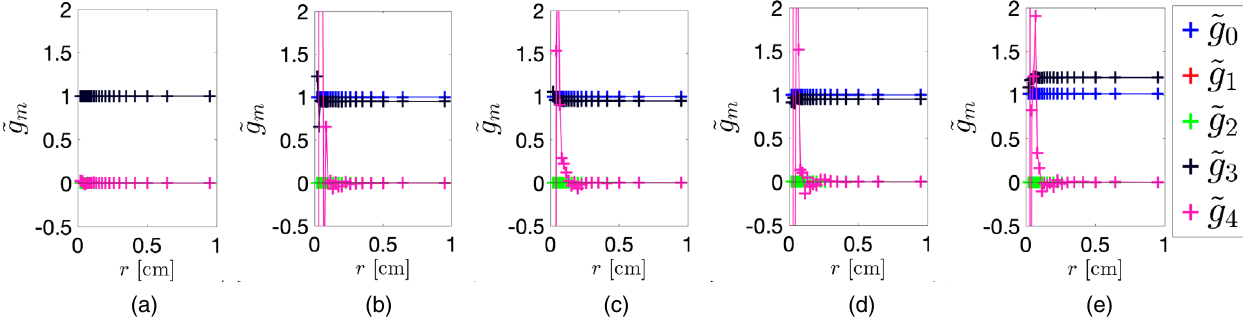
FIG. 7. The calculated multipolar coefficient, ˜ g cavities operating in the TM 310 and four different TM